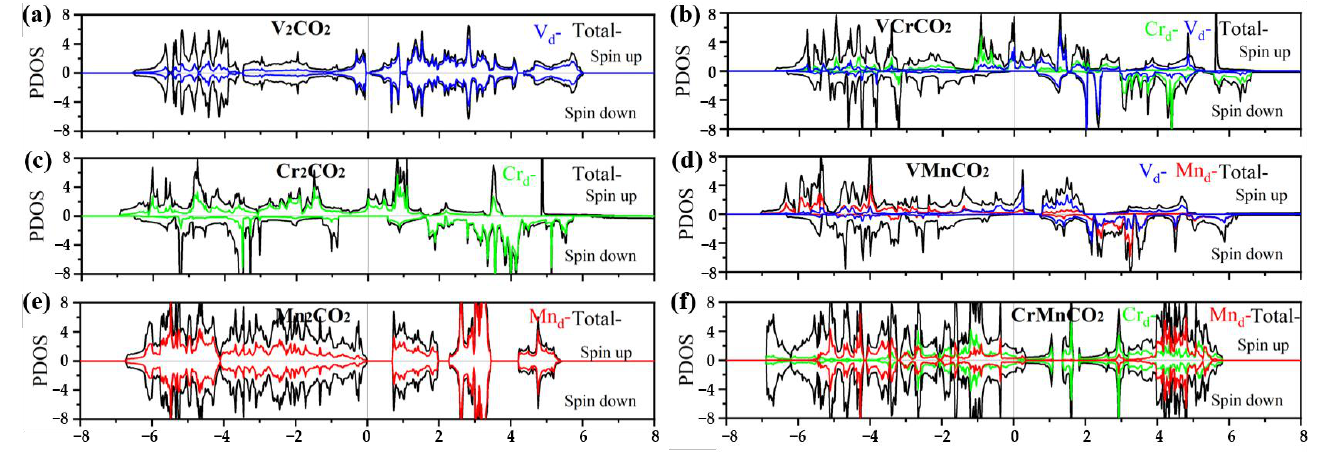
Figure 6. DOS of M ’ MCO 2 . ( a ) V 2 CO 2 ; ( b ) VCrCO 2 ; ( c ) Cr 2 CO 2 ; ( d ) VMnCO 2 ; ( e ) Mn 2 CO 2 ; ( f ) CrMnCO 2 .